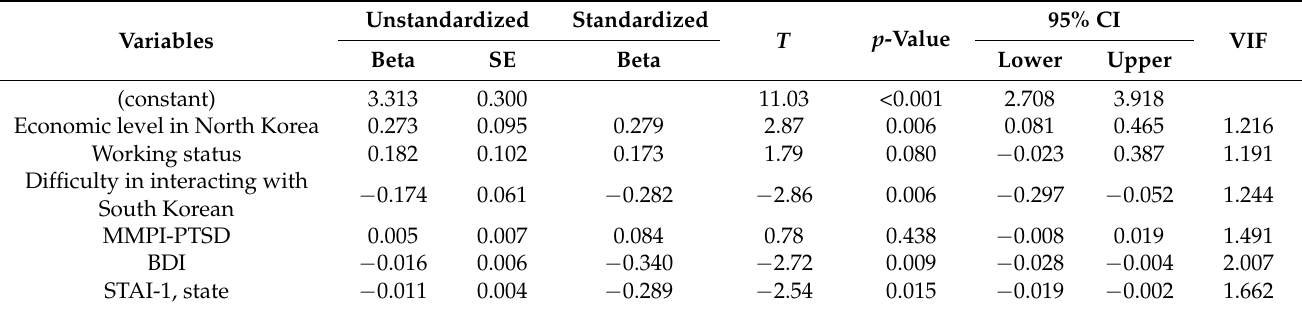
Table 3. Regression of variables to predict quality of life in refugees from North Korea (adjusted R 2 =